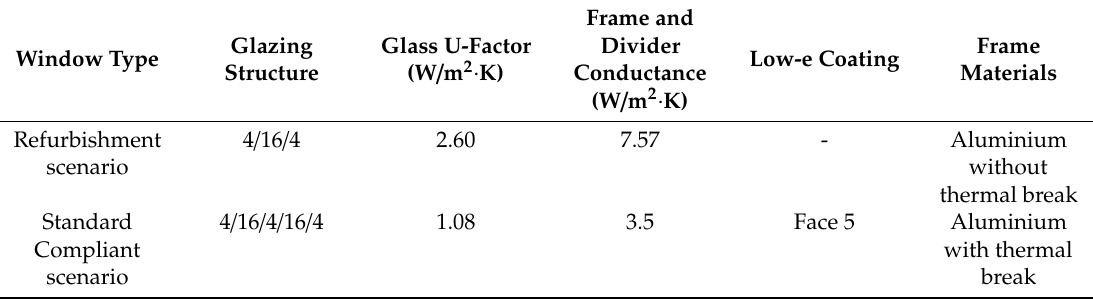
Table 1. Glazing, frame, and dividers properties. All the cavities between glass panes were considered filled with argon gas. Conductance was calculated excluding surface convection resistance.